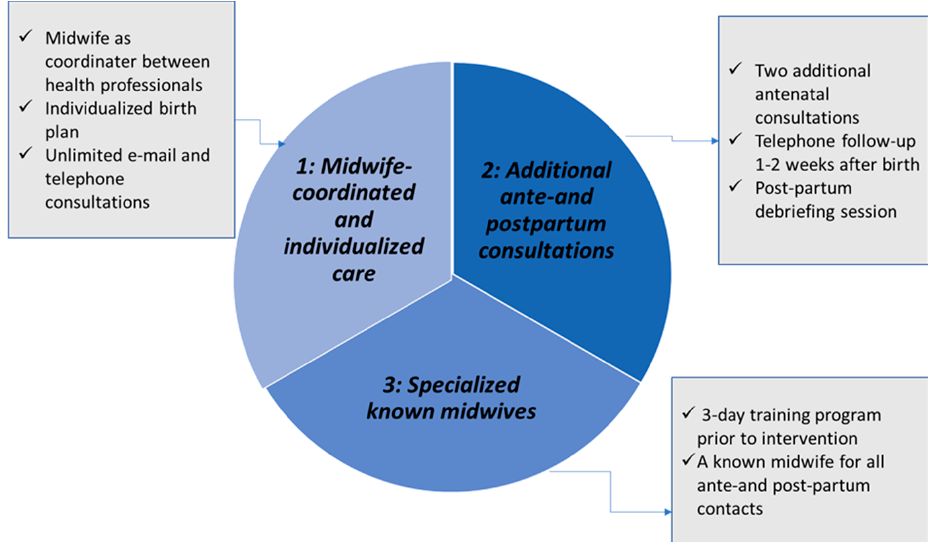
Figure 1. Main components of the ChroPreg intervention.